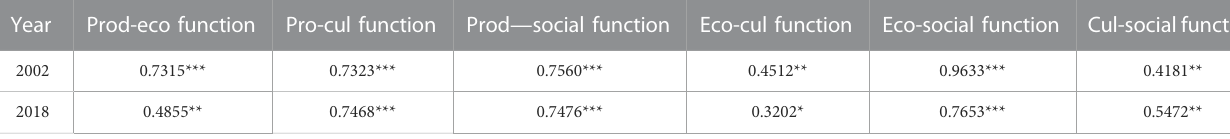
(1)The values in the table are the Spearsman correlation coef fi cient (2)***, **, * stand for the signi fi cance levels at 1%, 5% and 10%, respectively.